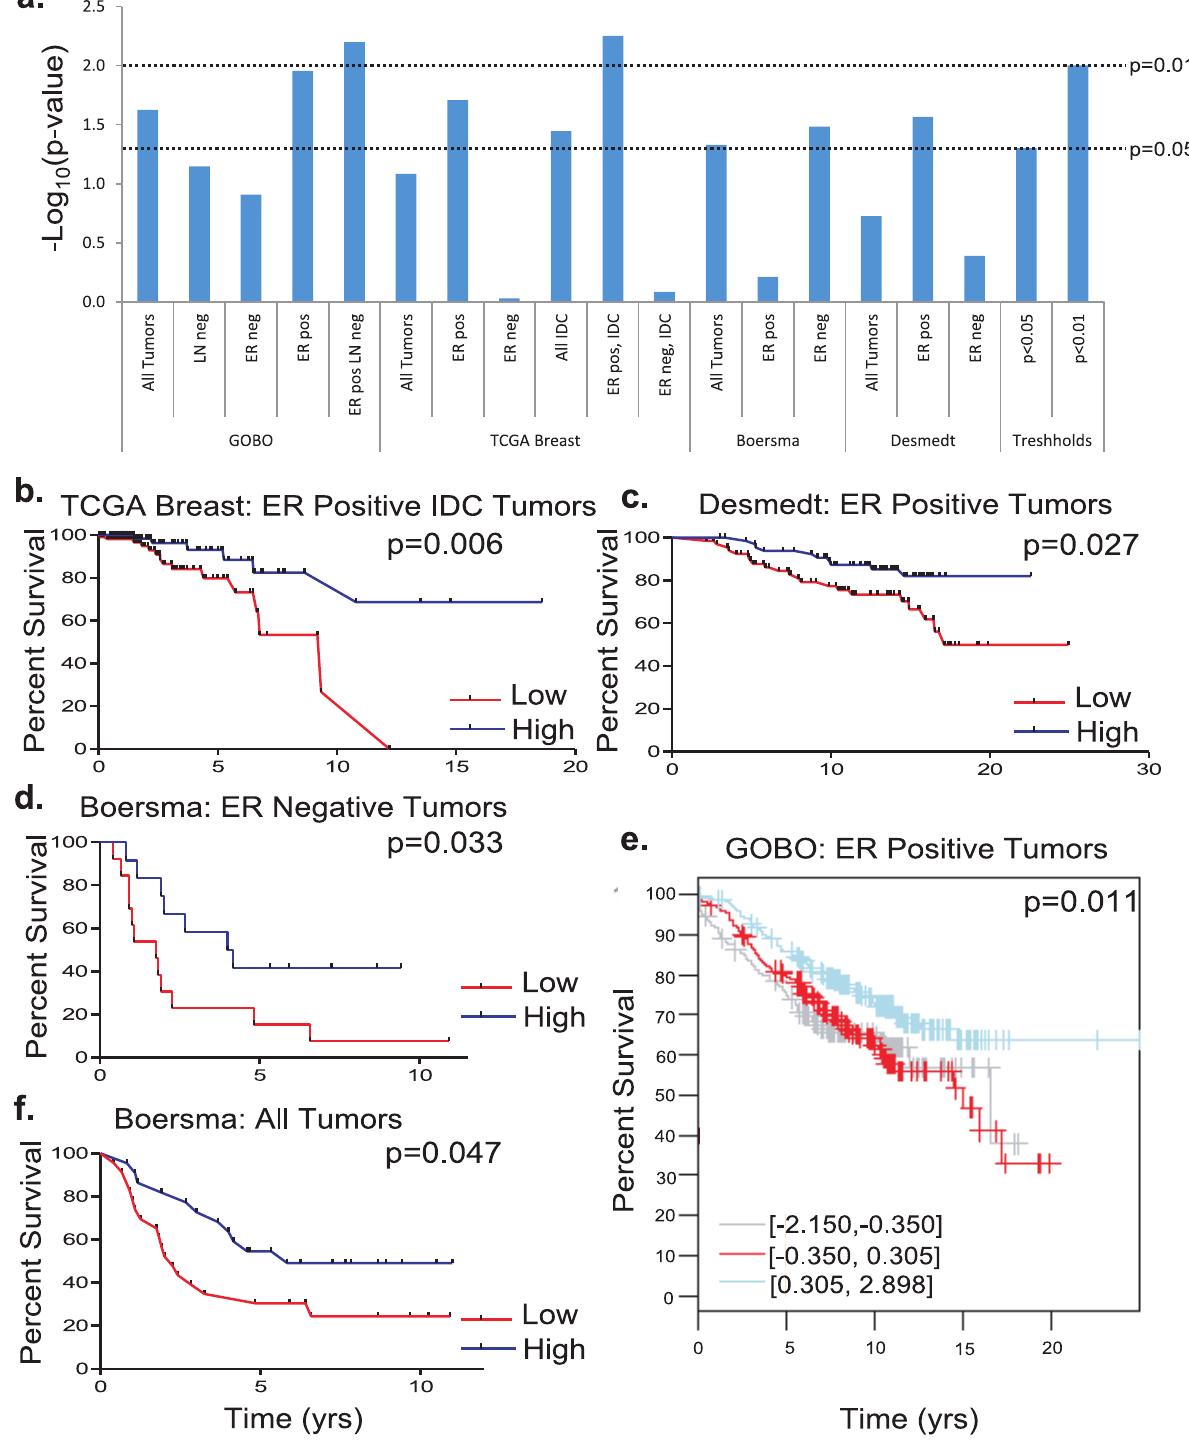
Figure 7. The effect of Cadm1 expression levels on survival in patient datasets. (a) Compiled results of -Log 10 transformed p-values for all survival analyses. Kaplan-Meier plots of (b) estrogen receptor (ER) positive invasive ductal carcinoma (IDC) tumors from the Oncomine TCGA set, (c) ER positive tumors from the Desmedt set, (d) ER negative tumors from the Boersma set, (e) ER positive tumors from GOBO, (f) all tumors from the Boersma set.